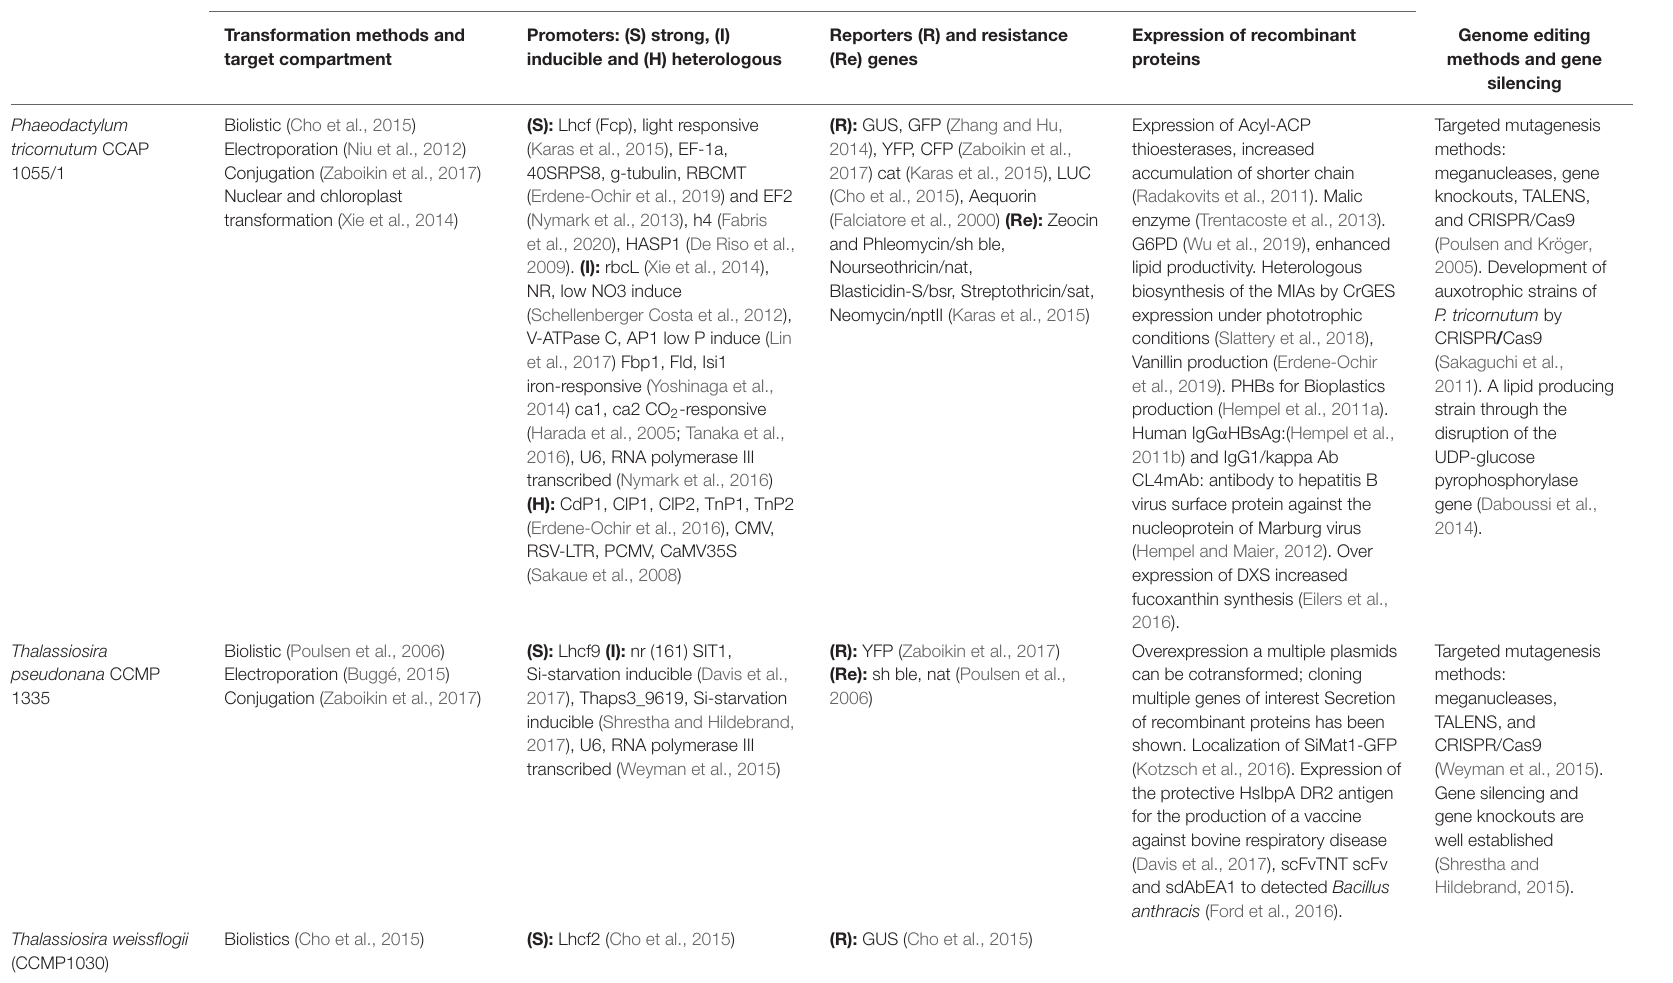
TABLE 5 | Diatoms genetic engineering. Species/strain Genetic and molecular